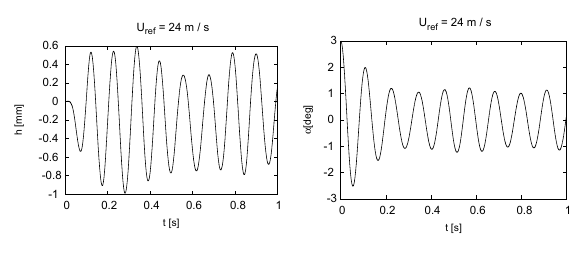
Fig. 14. Aeroelastic response for the seconde considered case in terms of h and α in time domain for far field velocity U ∞ = 24 m / s